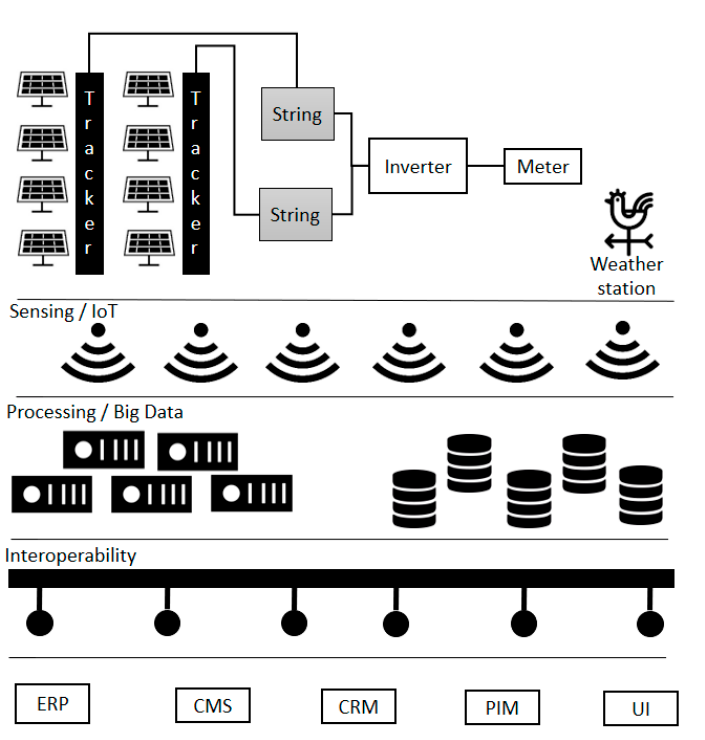
Figure 1. Industry 4.0 architecture deployed in a photovoltaic